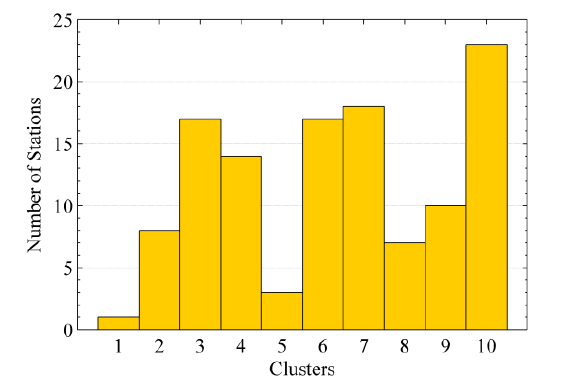
Figure 4. Number of stations in each cluster Variation in the sum of intra-cluster distances is exposed in Figure 5. As it can be seen in Figure 5, when the number of clusters increases, the cost function also decreases.